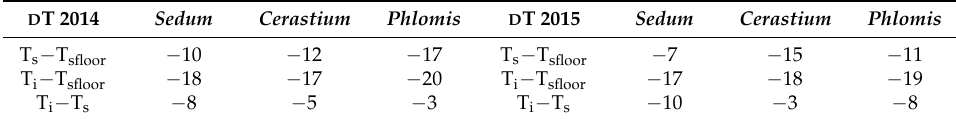
Table 4. Thermal gradients between paved surface T sfloor , plots T s and T i .